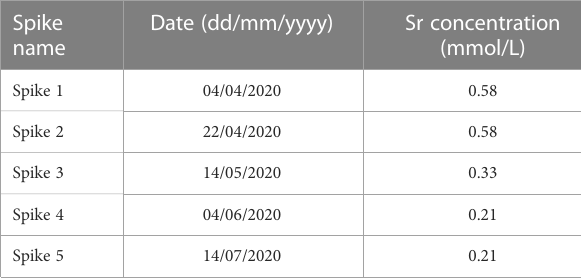
TABLE 1 Overview of dates and concentrations of Sr spikes administered to the cultured